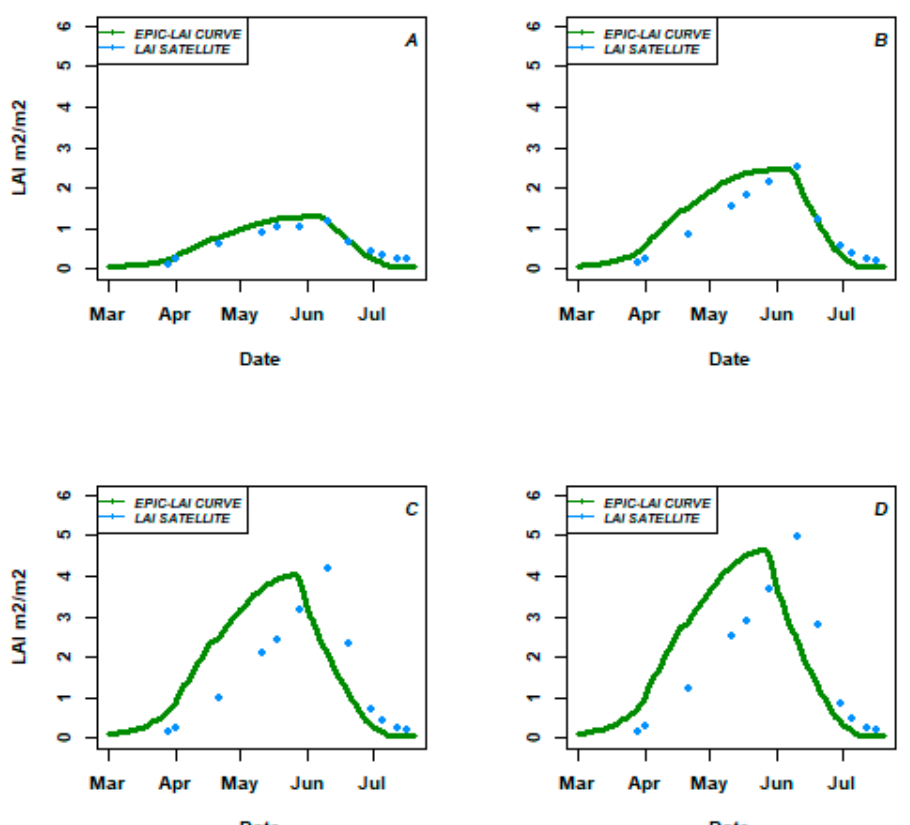
Figure 5. Assessment showing the different LAI values in four 2017 plots for different levels of fertilization: 0 kg N/ha ( A , id: 1-1), 60 kg N/ha ( B , id: 2-1), 120 kg N/ha ( C , id: 3-1), and 180 kg N/ha ( D , id: 4-1). The green line is the daily LAI curve obtained by EPIC model while the light blue points are the LAI measurements obtained using Sentinel-2 data.